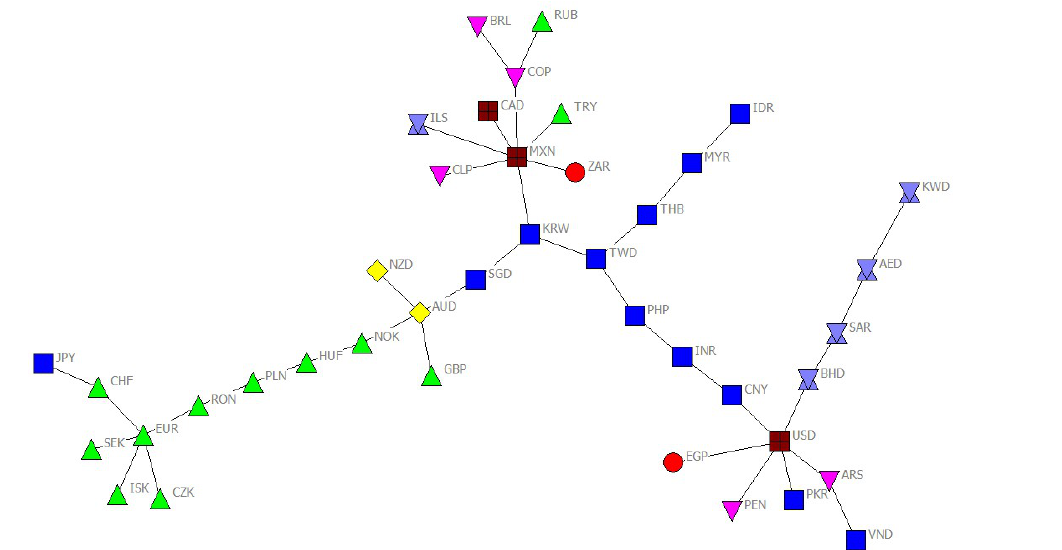
Figure 4. FX network during 12 May 2015–15 December 2015, as a representative event of the CNY joining the special drawing rights.